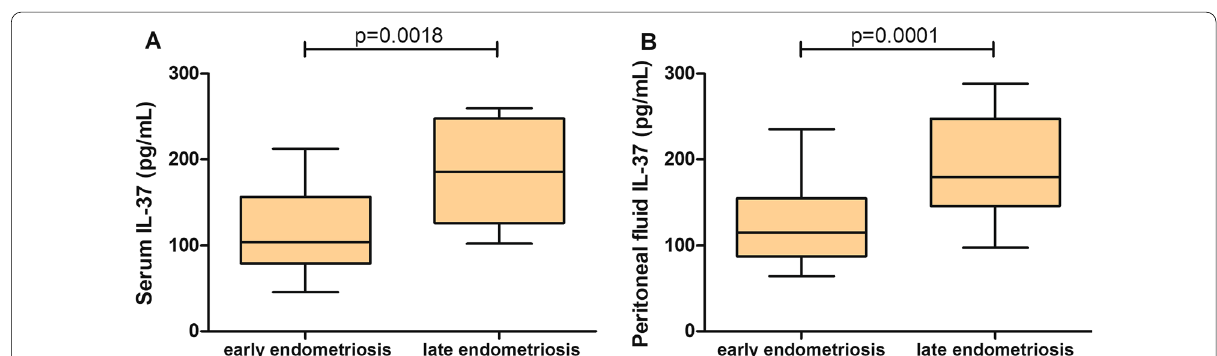
Fig. 2 Higher levels of serum ( A ) and peritoneal fluid ( B ) IL-37 in late stages of endometriosis